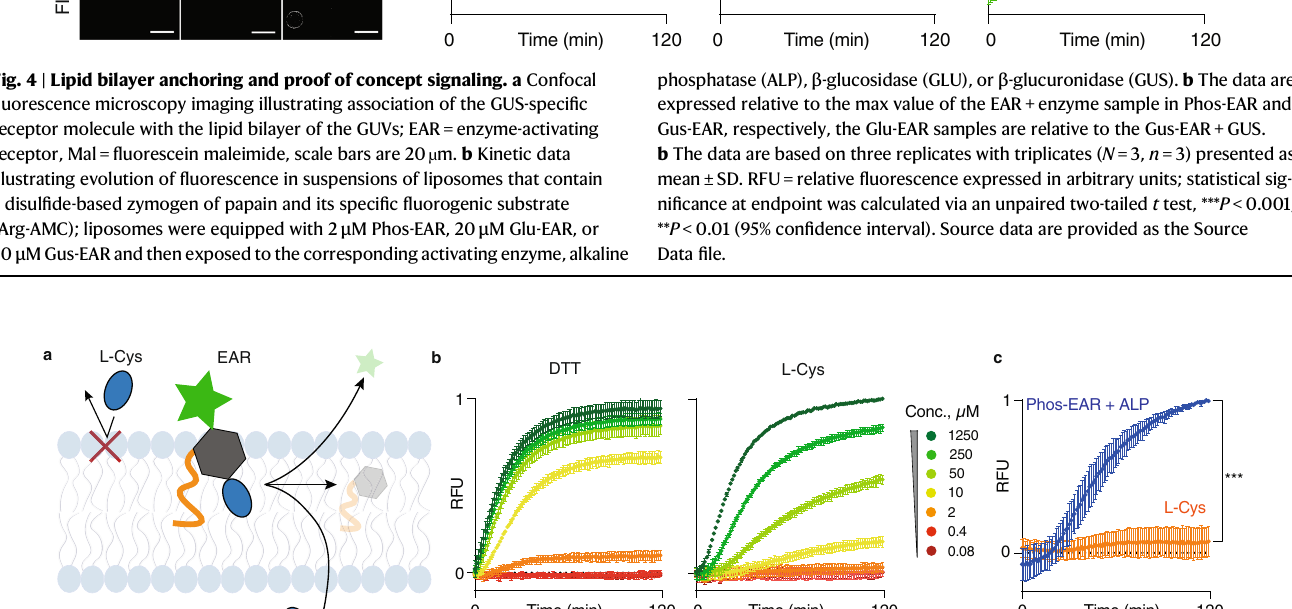
Fig. 5 | Receptor-mediated vs diffusive signaling. a Schematic illustration of diffusive signaling by L-Cys vs receptor-mediated signaling by Phos-EAR. b , c Fluorescenceintensityevolutionpro fi lesinsolutionsofliposomesthatcontain the disul fi de-based zymogen of papain and the protease substrate (Arg-AMC); zymogen activation is performed by DTT or L-Cys via diffusion across the lipid bilayer( b ) orcomparing 2 μ M L-Cys to 2 μ M Phos-EAR installedinto the liposomes